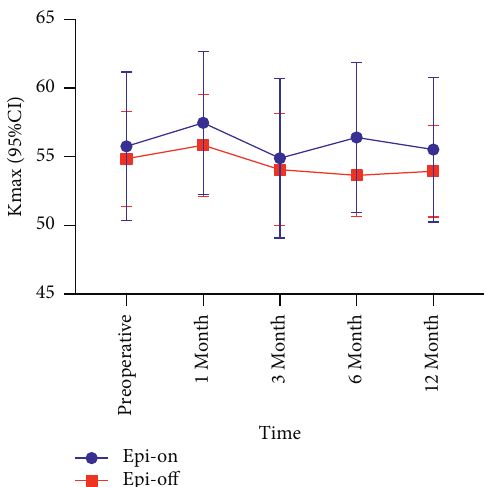
Figure 2: Comparison of Kmax during the 12-month follow-up period. Kmax: Maximum keratometry; CI: confidence interval.